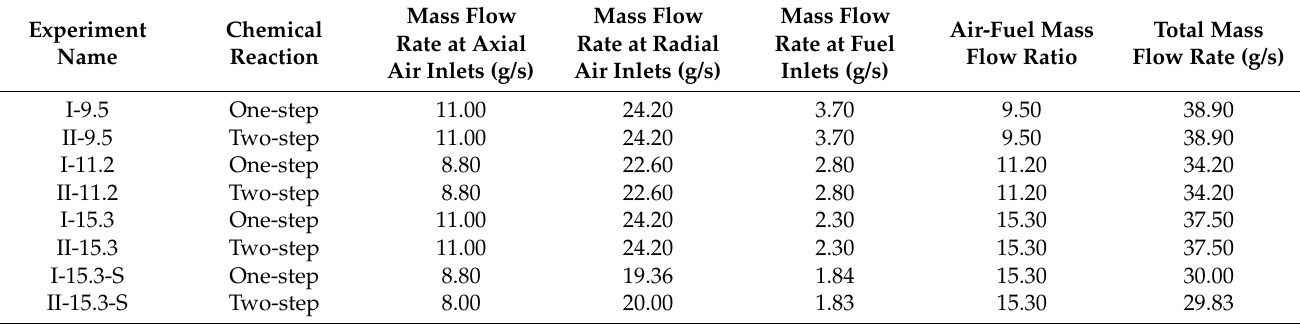
Table 2. Experimental program and parameters.